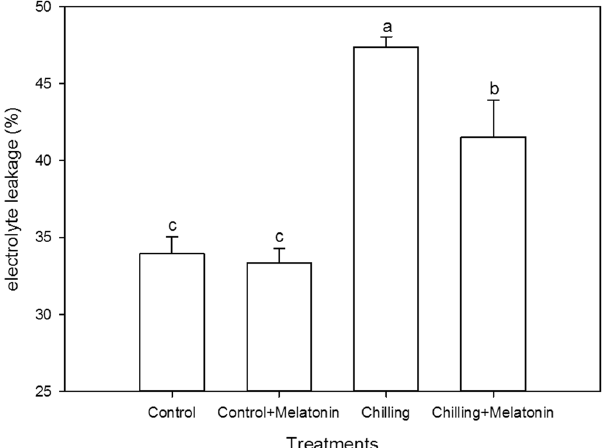
Figure 1. Effects of exogenous melatonin on electrolyte leakage after eight days chilling treatment. Control, treating at 28/18 °C; Control + Melatonin, pre-treating with 200 μ M melatonin and treating at 28/18 °C; Chilling, treating at 15/8 °C; Chilling + Melatonin, pre-treating with 200 μ M melatonin and treating at 15/8 °C; Date represent means ± SD of third replicate samples. Different letters indicate a significant difference in a particular series at P < 0.05 according to ANOVA and Duncan’s multiple range